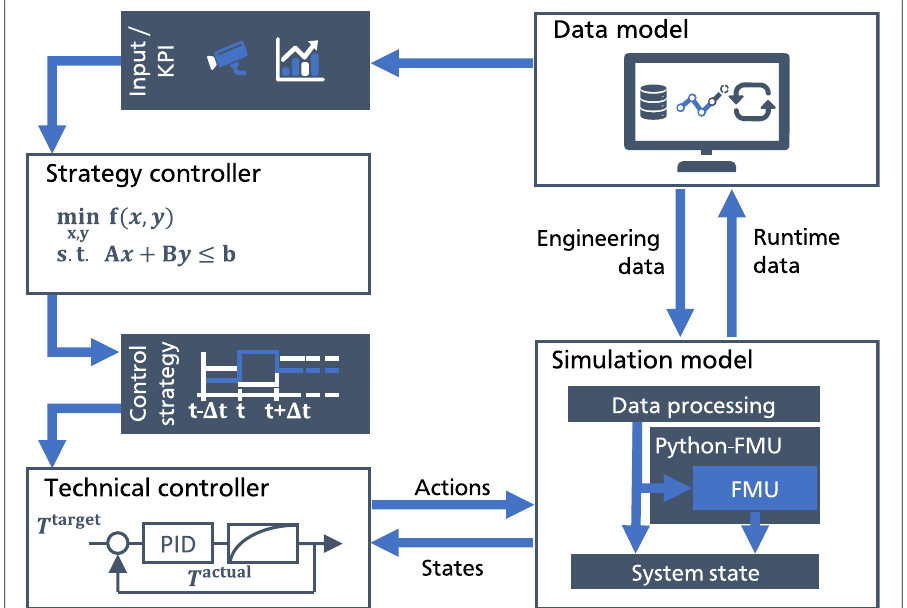
Fig. 4 Two stage control approach of the heat transfer station with connection to the data and simulation model. The simulation model is integrated as a functional mock-up